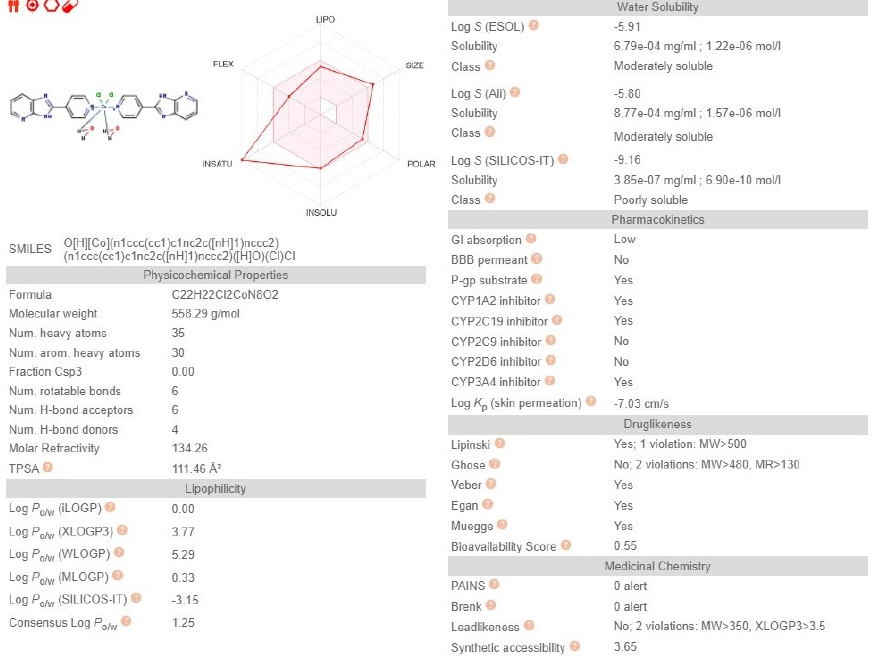
Figure 11. ADME for C1 .